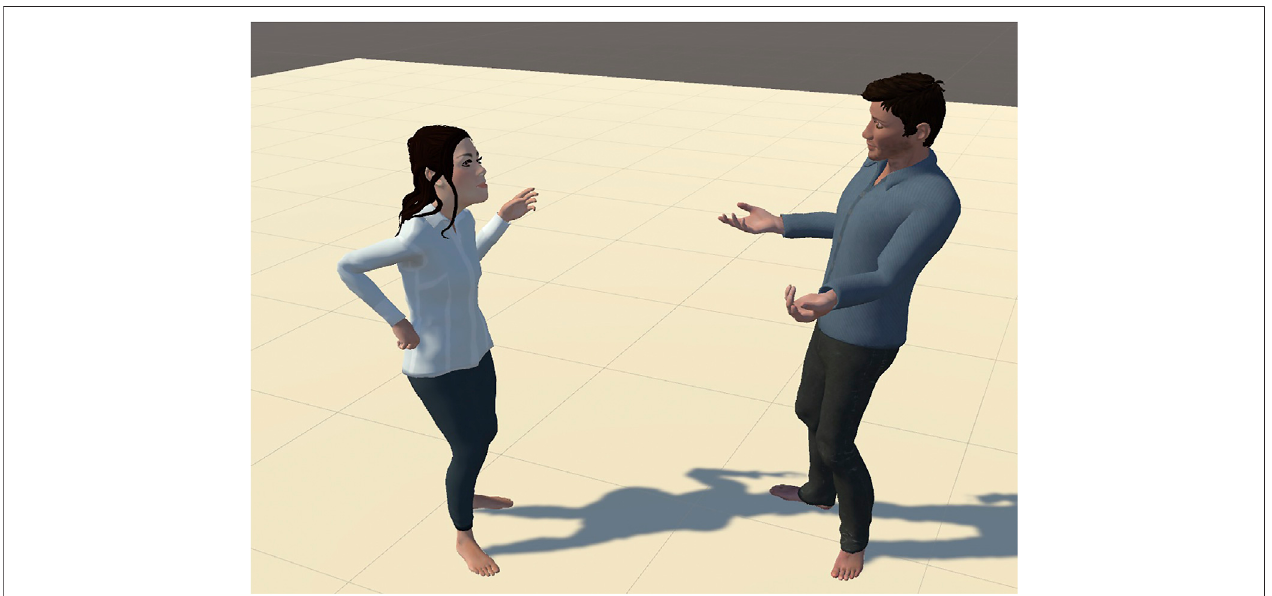
FIGURE 1 | The fi gure shows the third person view of two customized humanoid avatars in the brainstorming task.